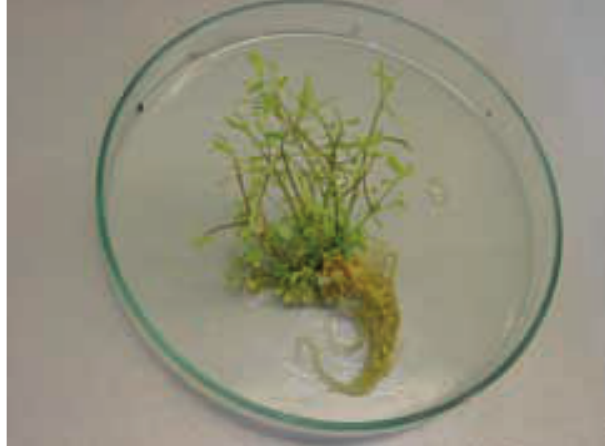
Fig. 4. Rooting in vitro of Atriplex halimus